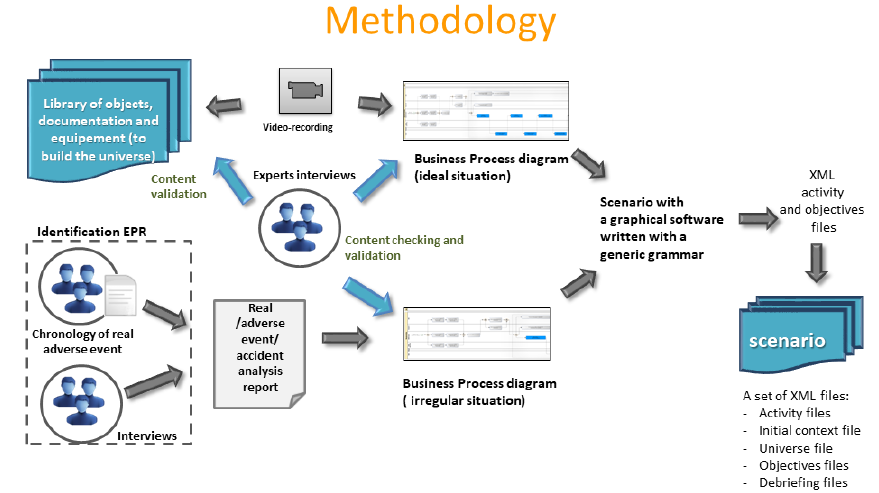
Fig. 1. Methodology used to design a risk management scenario based on an real surgery